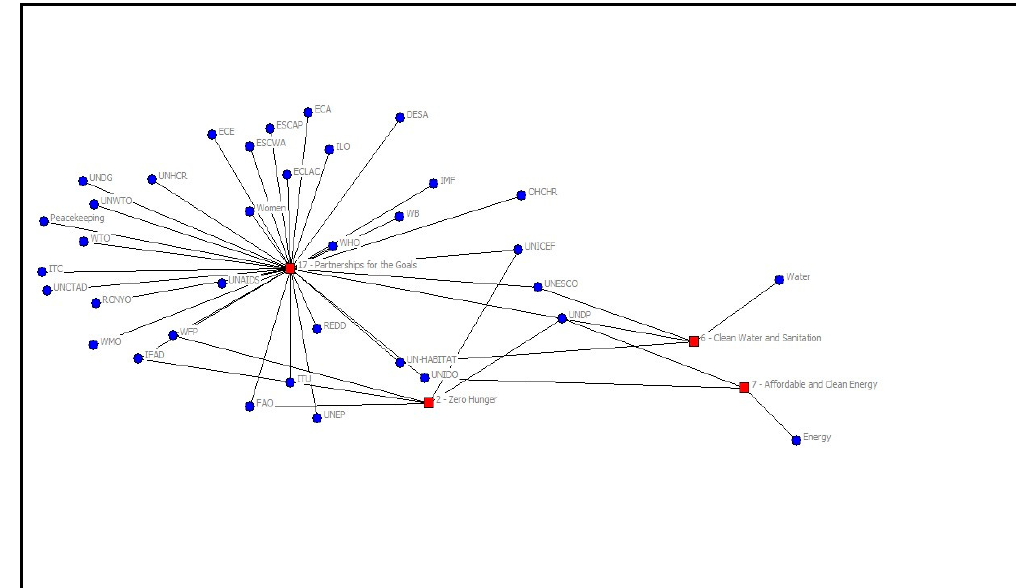
Figure 5. SDGs—FEW and partnership network.